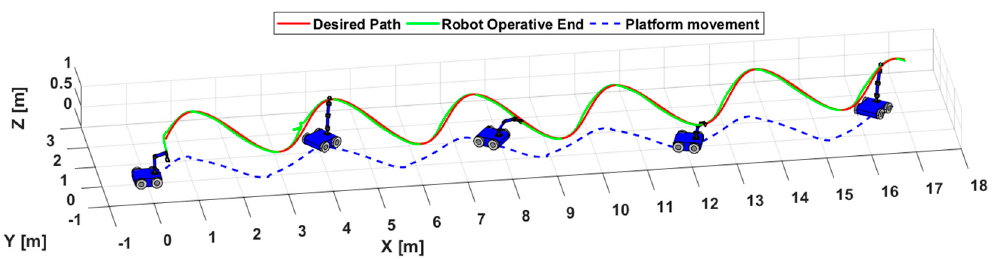
Figure 22. Strobe movement of the execution of the third experiment considering ROC analysis and manipulability.